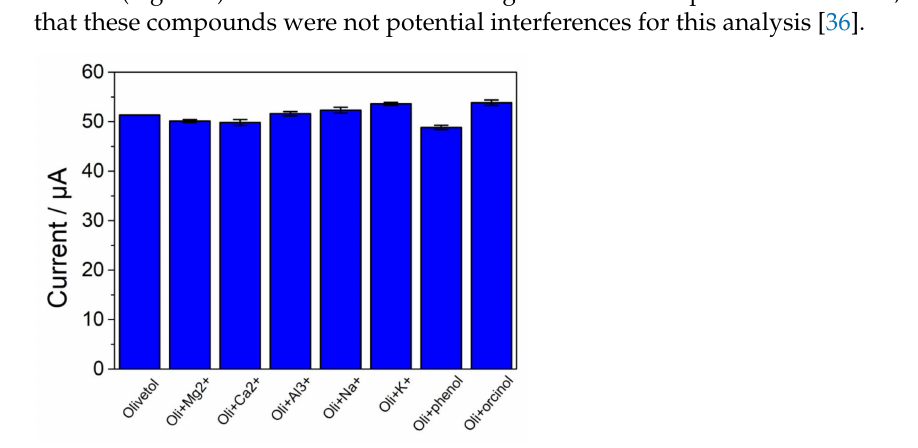
Figure 7. Peak current of p-L-serine/CuO/CPE in olivetol containing various interfering